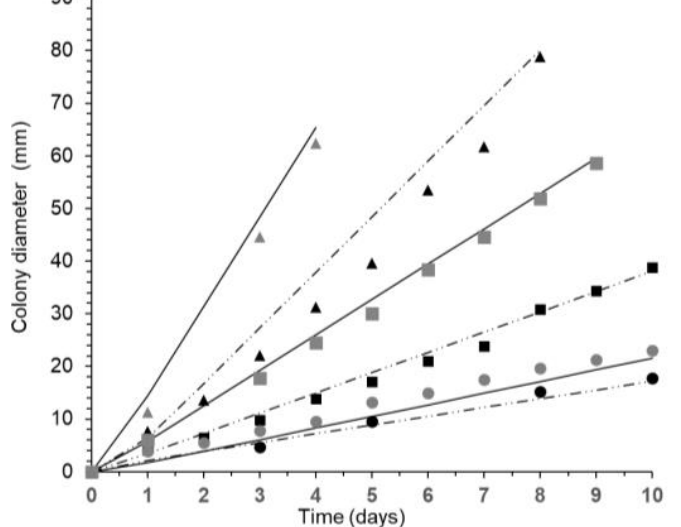
Figure 1. Fitted colony growth curves for F. asiaticum (strain 082) on wheat-based media at 35 °C